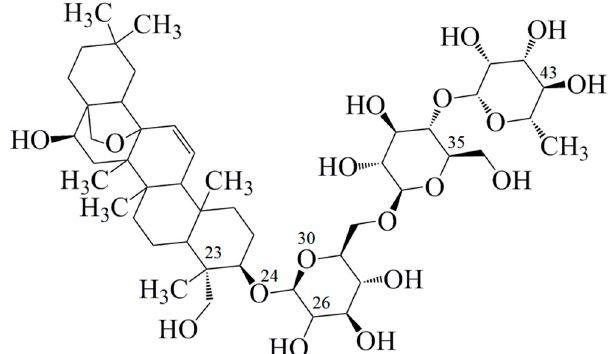
Figure 1. Chemical structure of saikosaponin C (C 48 H 72 O 17 , molecular weight 920, numbered using ChemDraw software).